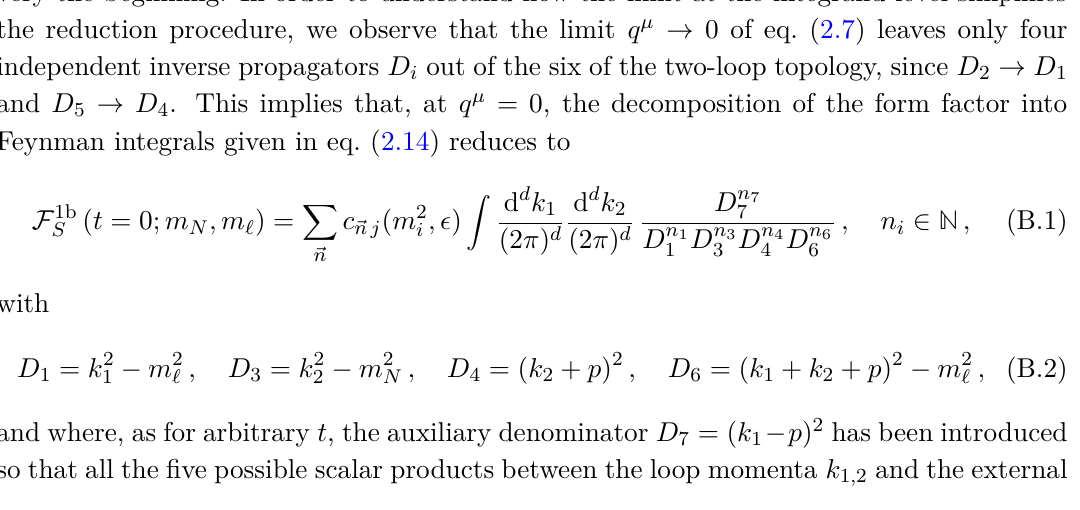
= 1 in the fermionic S